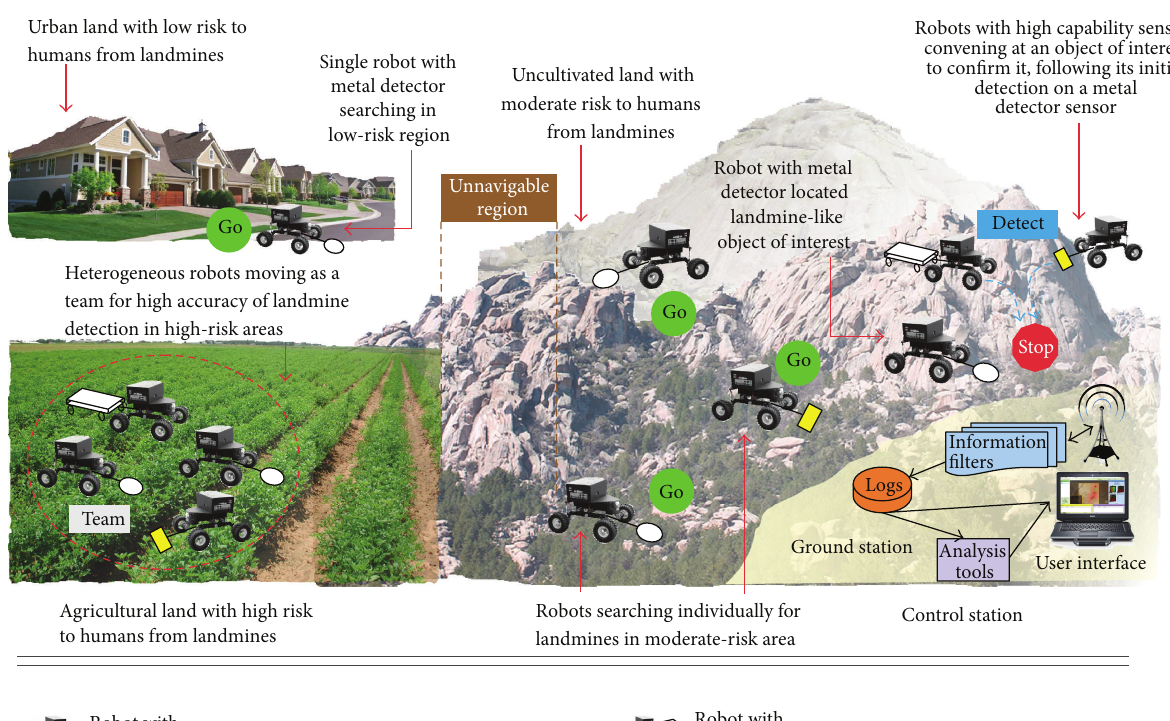
Figure 1: General schematic of the COMRADE system for landmine detection using multiple, autonomous, and mobile robots.